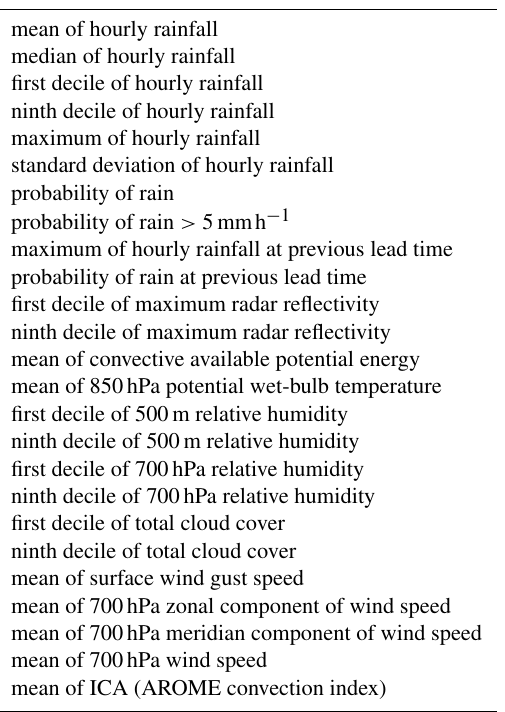
Table 2. Predictors involved in HCA-based PEAROME post- processing. The target variable is hourly